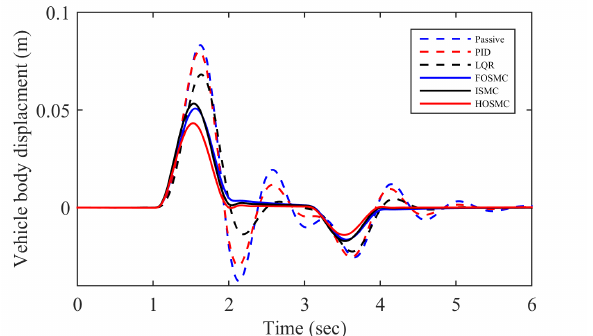
Figure 7. Vehicle body displacement.